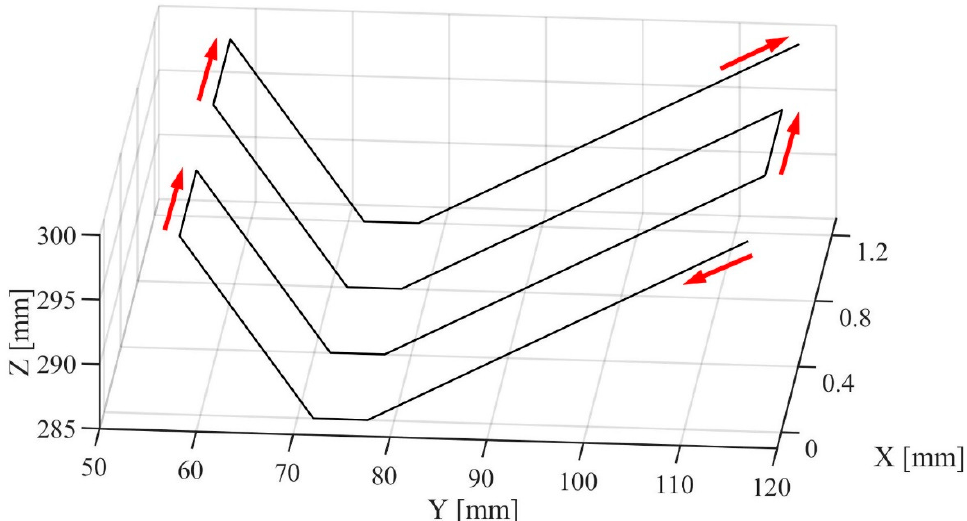
Figure 3. The Valley toolpath consisting of four identical segments in the YZ working plane with adjacent segments connected by a constant offset of 0.4 mm in the X-axis. This toolpath is an example of the zig-zag milling strategy. The angle sizes at Z = 285 mm (the bottom of the valley) are 159.5° and 135°. The direction of the toolpath is indicated by red arrows.